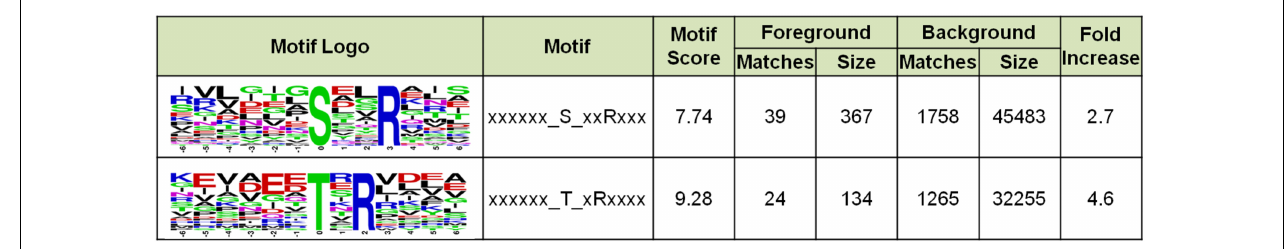
FIGURE 8 | Motif enrichment analysis of the identified phosphorylation Ser and Thr sites in this study. Ser and Thr at specific positions in modified-13-mers (6 amino acids upstream and downstream of phosphorylation site) for all identified protein sequences were collected, and all the database protein sequences were used as the background database parameter. The software package MoMo (motif-x algorithm) was used for motif enrichment analysis. The minimum number of occurrences was set to